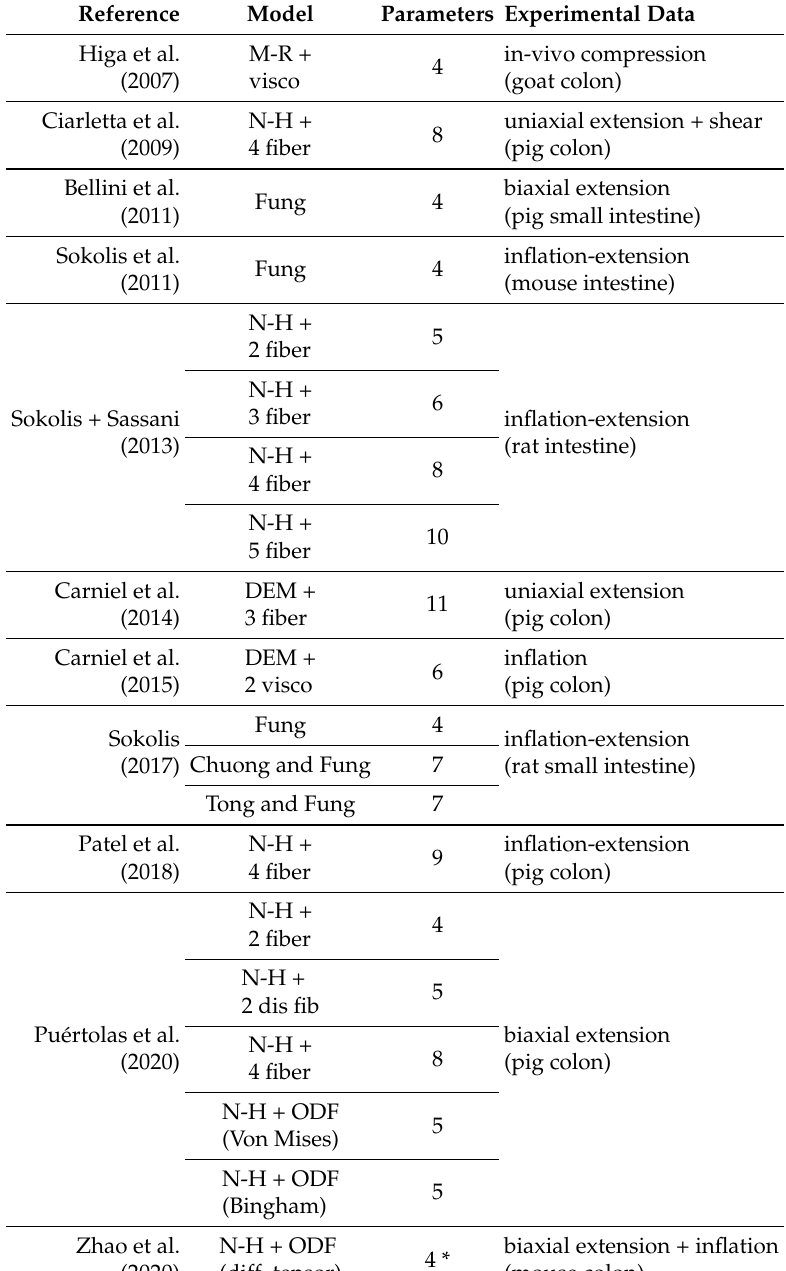
Table 1. Constitutive models applied to model colon tissues including the reference, the constitutive model, the number of parameters, and the experimental model used for determining the parameters (mechanical test and donor species); where DEM = Demiray; dis fib = exponentially stiffening family of fibers with dispersed orientations about the principal direction; fiber = exponentially stiffening family of fibers; M-R = Mooney-Rivilin; N-H = neo-Hookean; ODF = orientation distribution function (with function specified thereafter); and visco = viscoelastic (time dependent) addition to the hyperelastic model. * Specifying the diffusion tensor generally requires six parameters, but with assumptions these reduced to a single